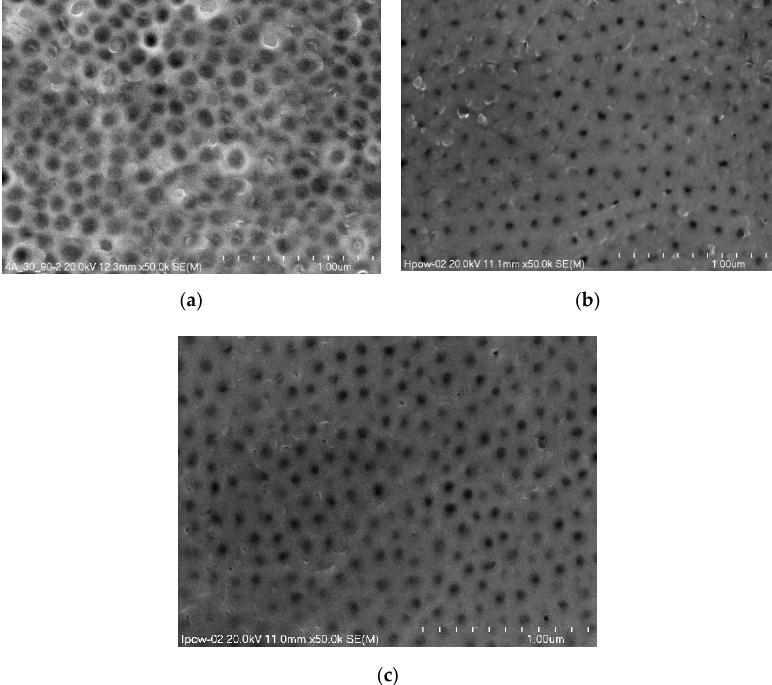
Figure 3. Surface morphology micrographs of oxide coatings without thermo-chemical treatment: ( a ) Sample 01D, ( b ) Sample 01H, ( c ) Sample 01J.